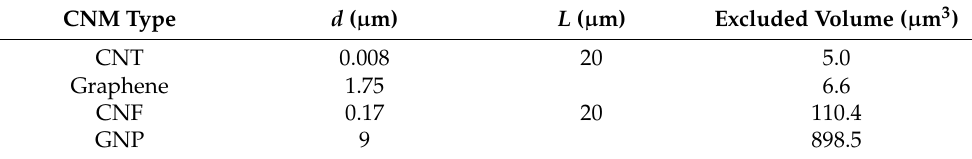
Table 5. Excluded volume determined by the geometrical features of the CNMs